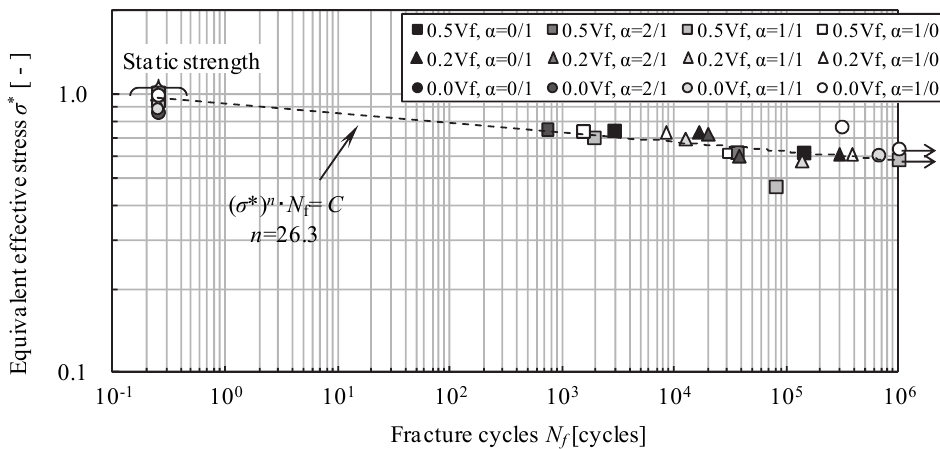
Figure 6: Relationships between σ * and N f with various α in I-SGP.